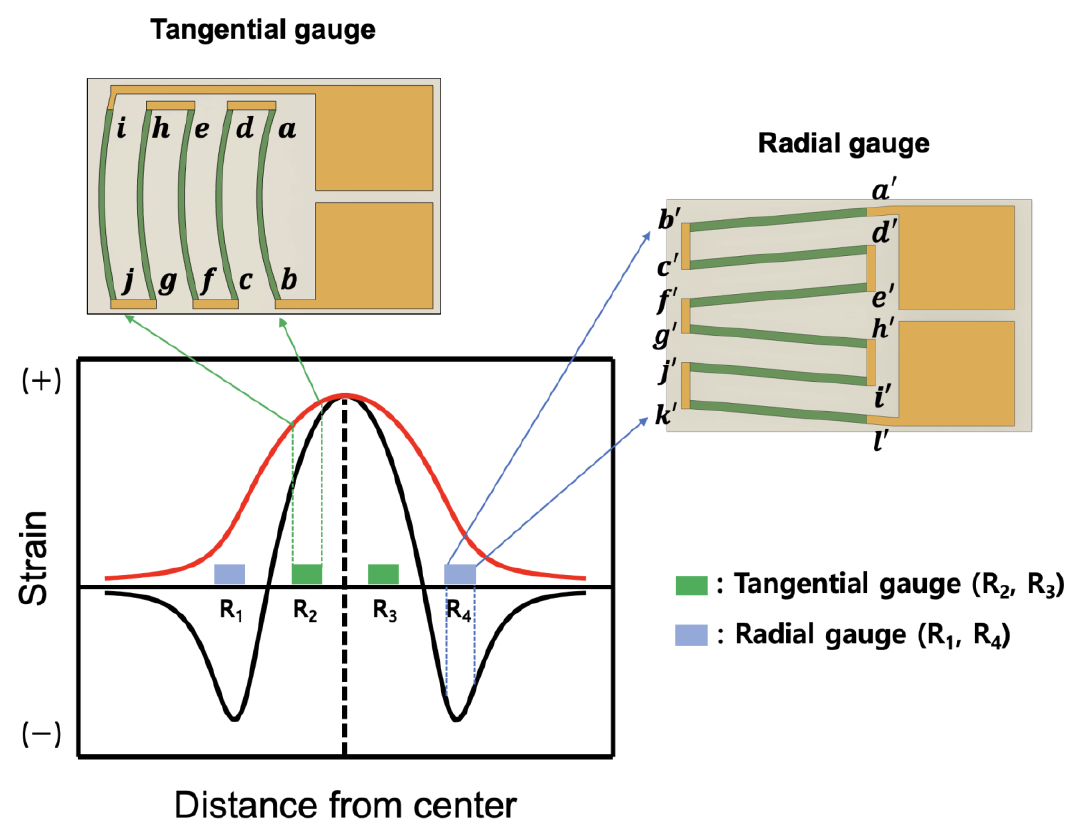
Figure 11. Simulated strain distribution and gauge locations on a stainless-steel circular diaphragm.